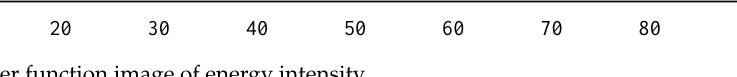
Figure 5. The transfer function image of energy intensity.